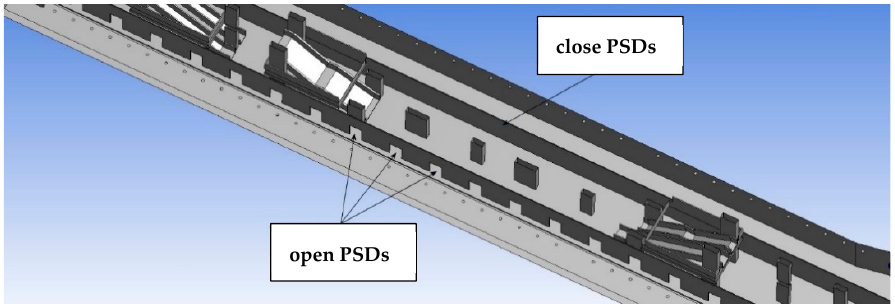
Figure 2. PSDs system considered to be installed on the platform of the station